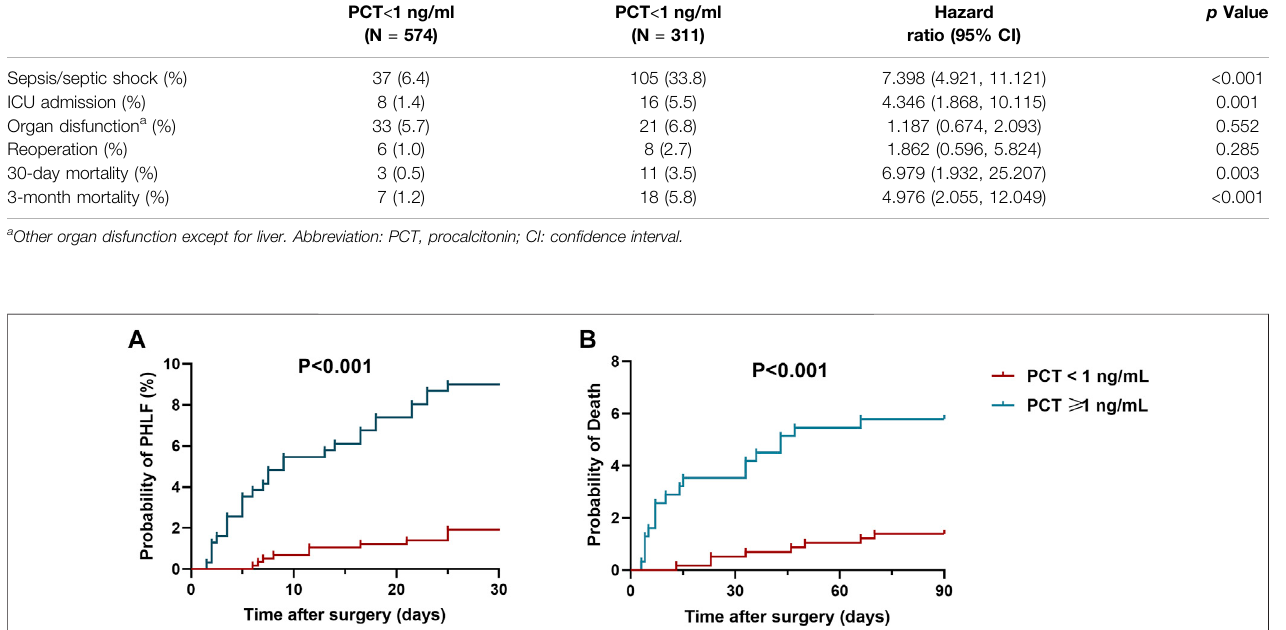
Frontiers in Pharmacology |